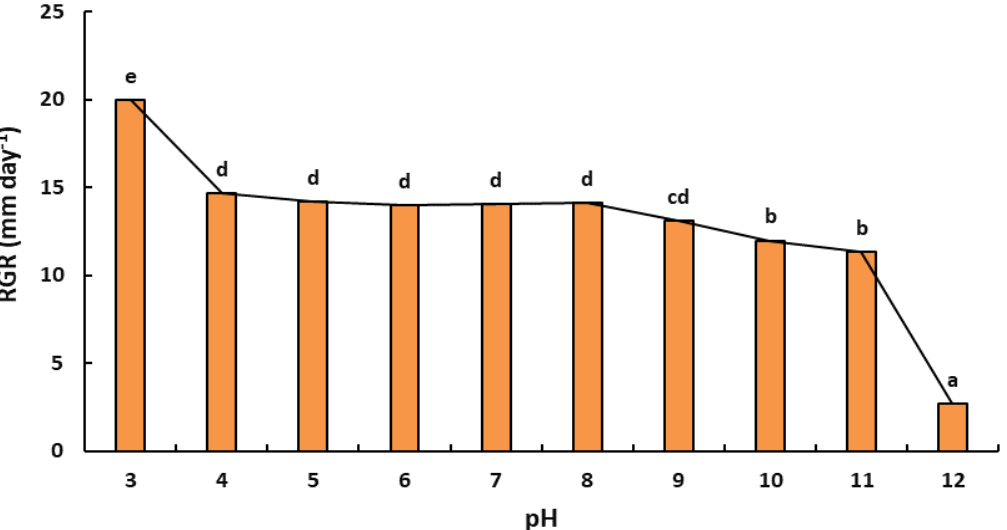
Figure 5. Plots of colony growth rate (mm day −1 ) versus pH for L. viticola . Datasets are the mean of three replicates. Error bars represented standard deviations. Treatments with the same letter are not significantly different according to the Tukey test p ≤ 0.05.